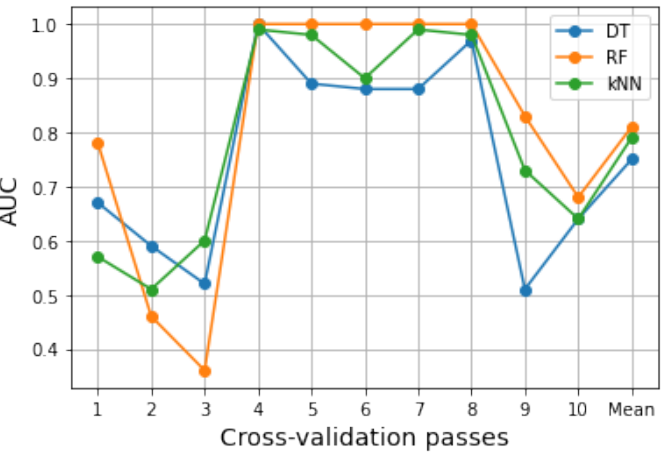
Figure 7. AUC with 10-fold cross-validation for the water treatment plant